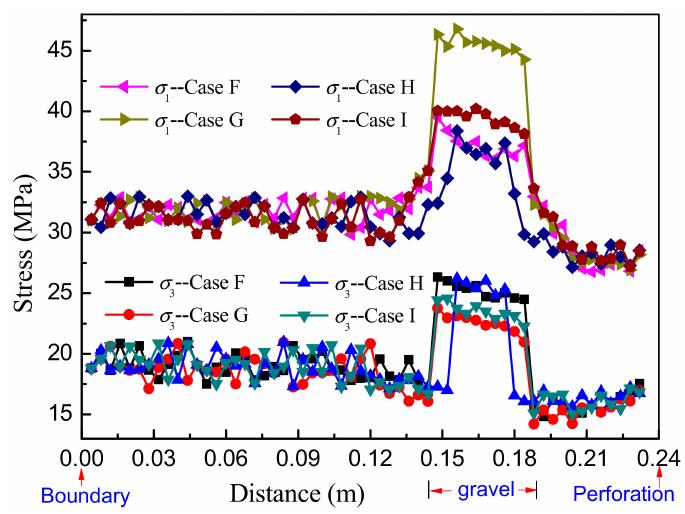
Figure 14. Principal stresses of elements along the blue dashed lines in Figure 13c–f. The boundary element is set as ordinate origin and the models are under initial hydraulic pressure 20.0